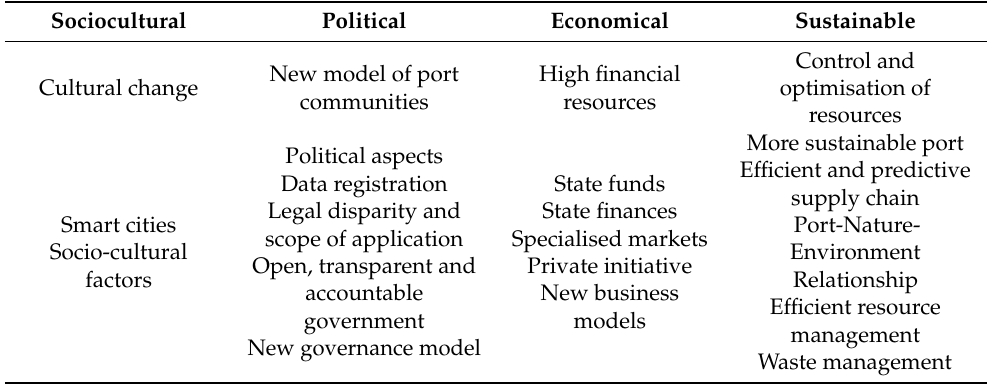
Table 5. Sociocultural, political, economical and sustainable parts of the BOT. Source: own